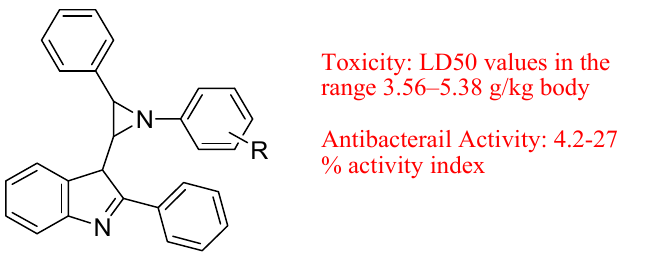
Figure 25. Bioactive spiro-2-[3 ′ -(2 ′